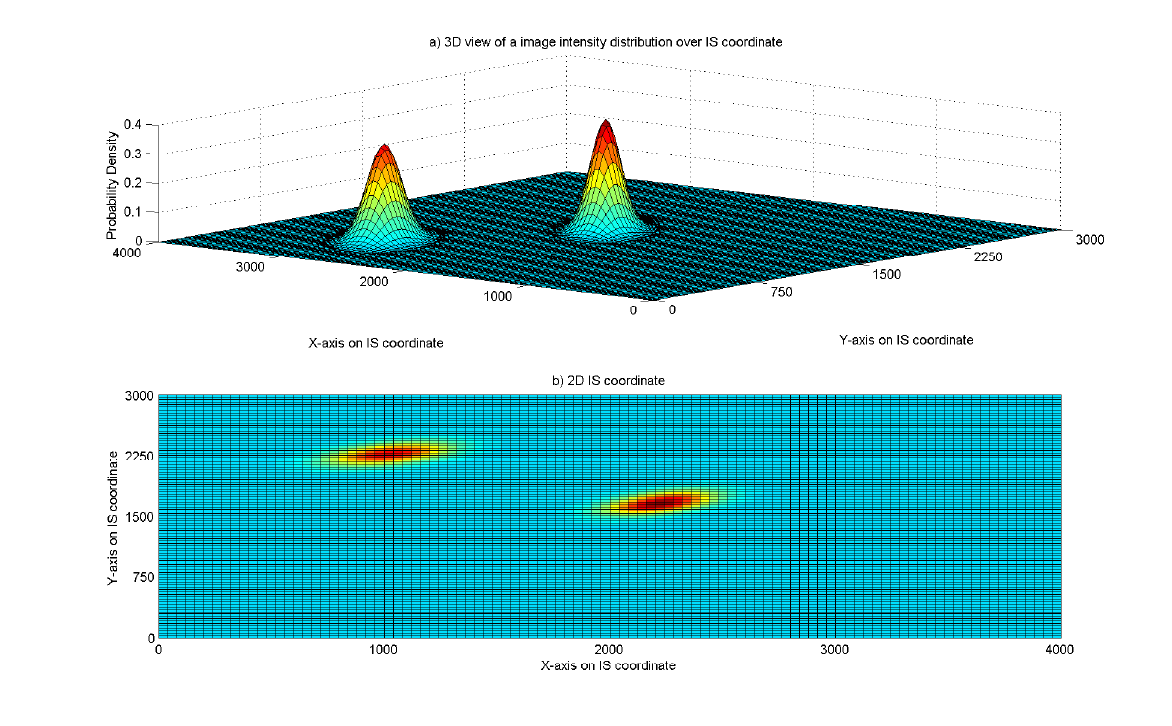
Figure 5. Pixel intensity distribution of a simulated